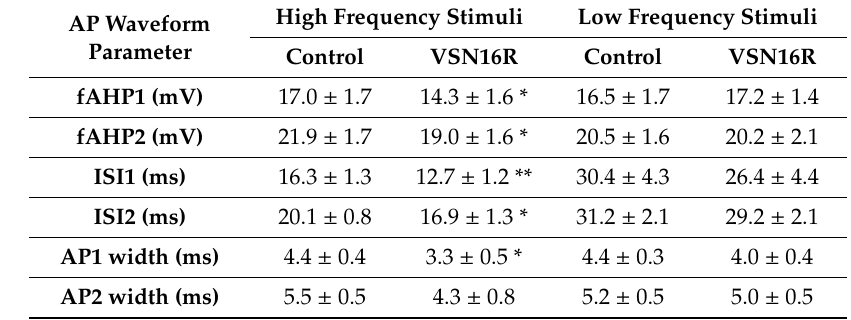
Table 1. Effects of (R,Z)-3-(6-(dimethylamino)-6-oxohex-1-en-1-yl)-N-(1-hydroxypropan-2-yl) benzamide (VSN16R) on action potential (AP) waveform parameters.